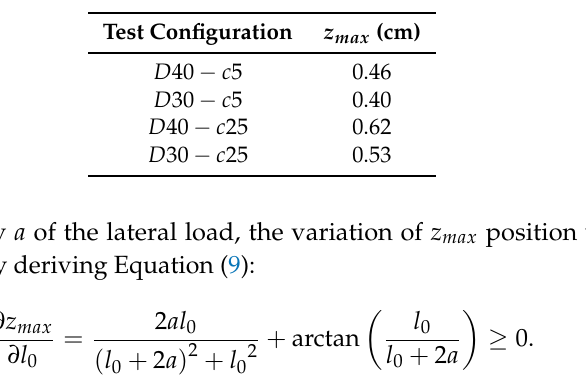
Table 2. Theoretical position of the maximum